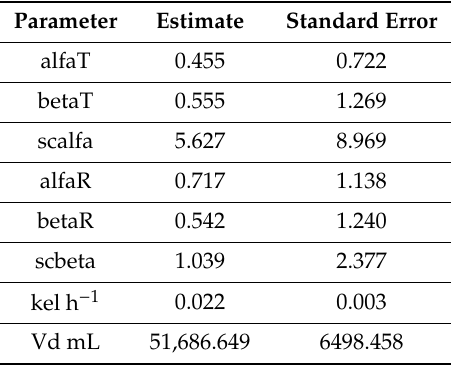
Table 8. Parameters of the